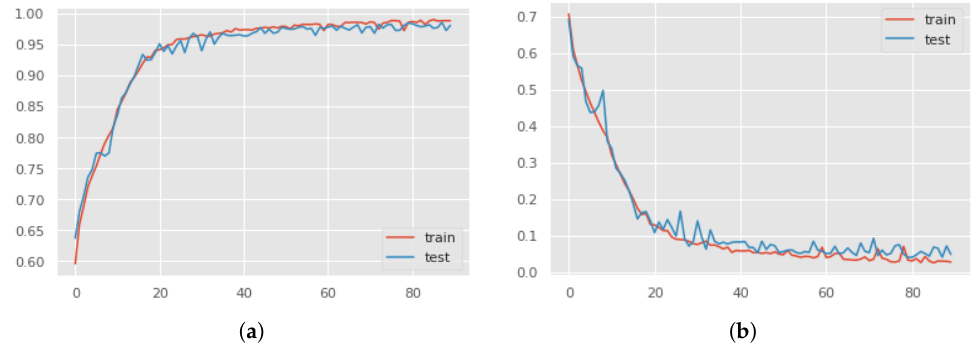
Figure 9. The accuracy curves ( a ) and the loss curves ( b ) computed with the magnitude of 3D accelera- tions as input signal using hot–cold mapping. The training and testing curves show a good fit, ruling out